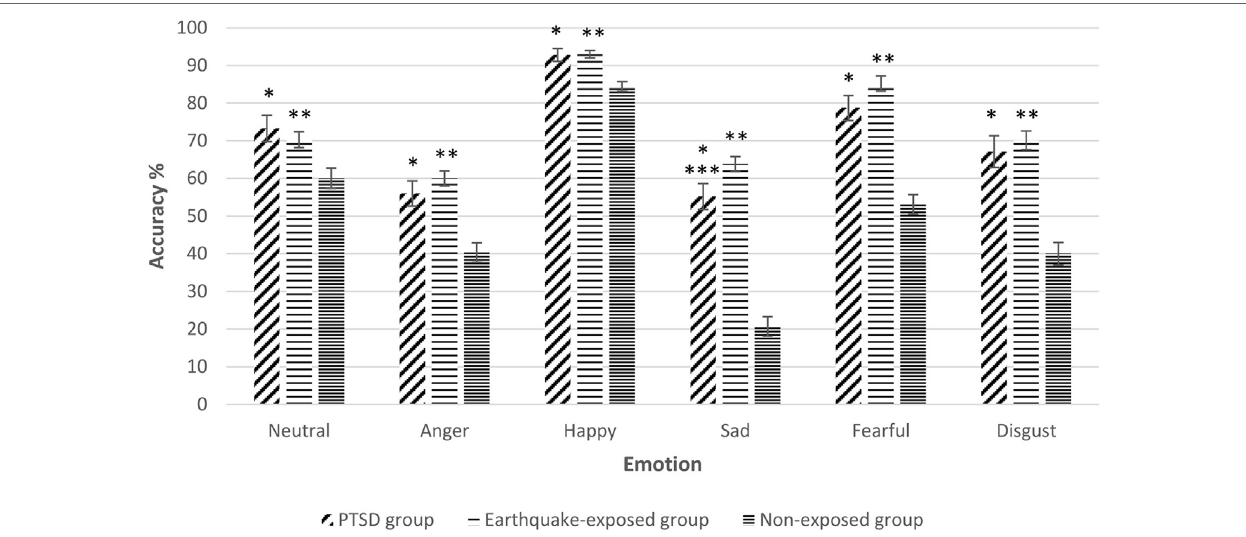
FigUre 1 | Gender, years of education, and age-adjusted recognition accuracy (mean and SEM) for the five expressions of emotion and neutral expressions on the facial expression recognition task in the three groups. Pairwise comparisons significantly different p < 0.05. *Posttraumatic stress disorder (PTSD) group significantly different from non-exposed group. **Earthquake-exposed group significantly different from non-exposed group. ***PTSD group significantly different from earthquake-exposed